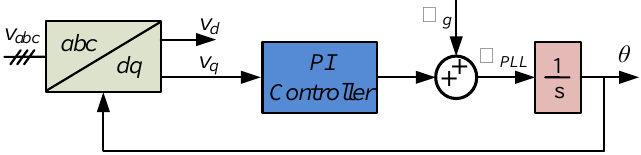
Figure 7. Structure of the synchronous reference frame phase-locked loop.